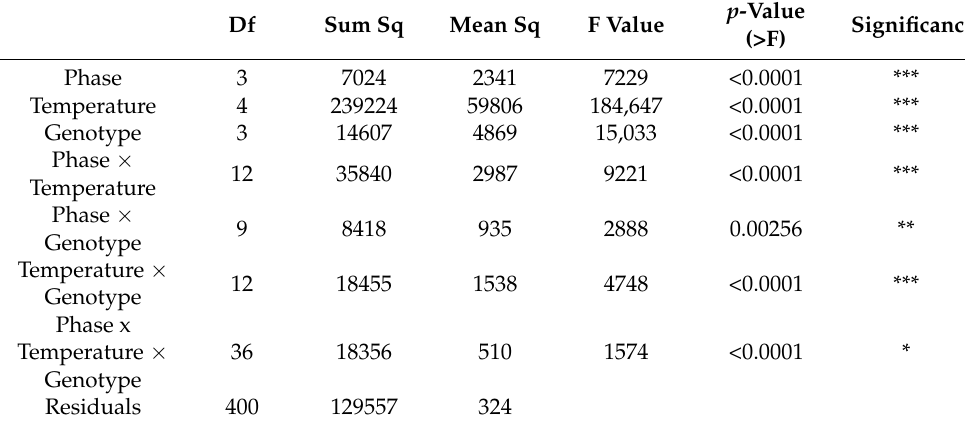
Table 2. Multi-factor analysis of variance of four lupin accession, one L. albus and three L. mutabilis , under the influence of developmental phase, temperature, and their